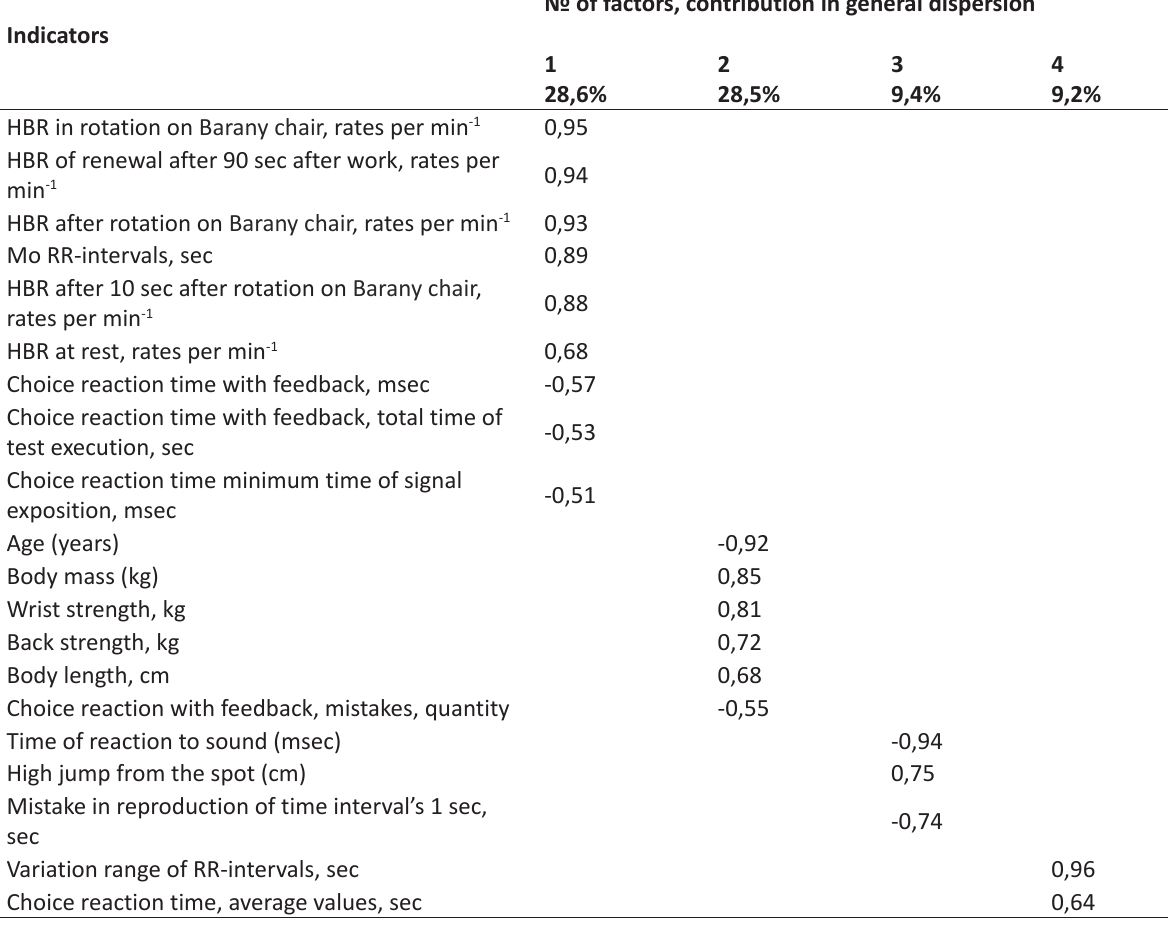
Table 1. The matrix of indicators’ components of qualified athletes (man) testing * (n = 19)